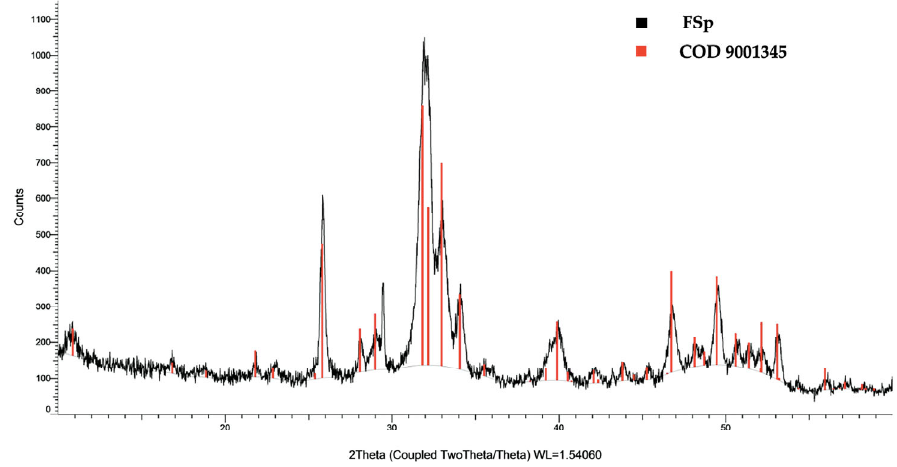
Figure 1. XRD pattern of FSp compared with COD 9001345.